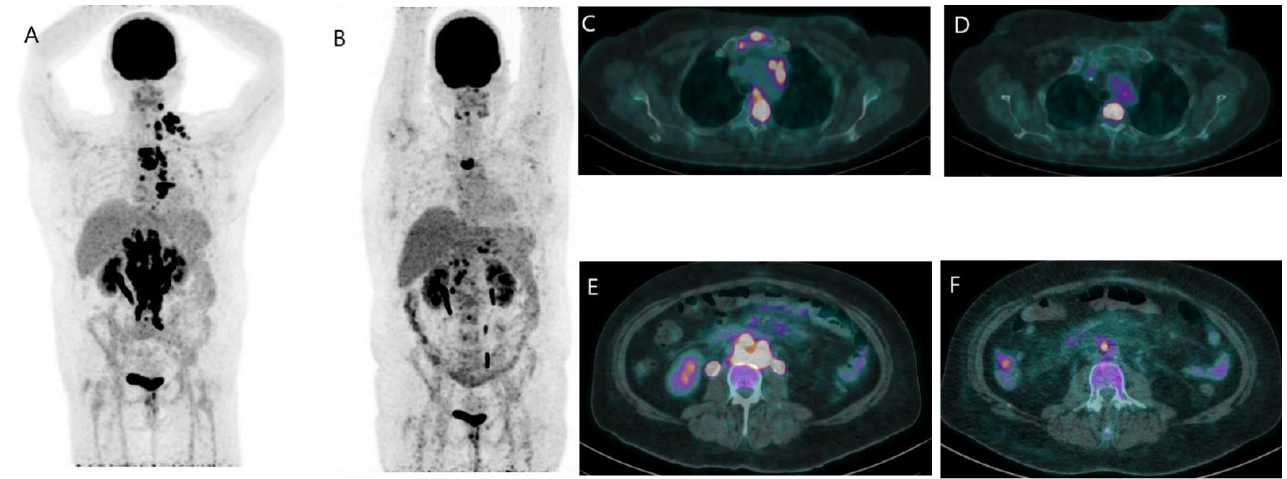
Figure 3. FDG PET/CT in evaluation of treatment response. A 47-year-old woman with metastatic HER2+ BR was treated by paclitaxel and pertuzumab and was referred for evaluation of treatment response. The PET/CT MIP images ( A , B ) show a significant partial metabolic response at 3 months of interval. Images ( C , D ) (fusion image, trans-axial view) show the regression of mediastinal adenopathy and sternum lesion and also the persistence of a bone lesion of T4. Images ( E , F ) (fusion image, trans-axial view) show the important regression of retroperitoneal lymph node involvement.